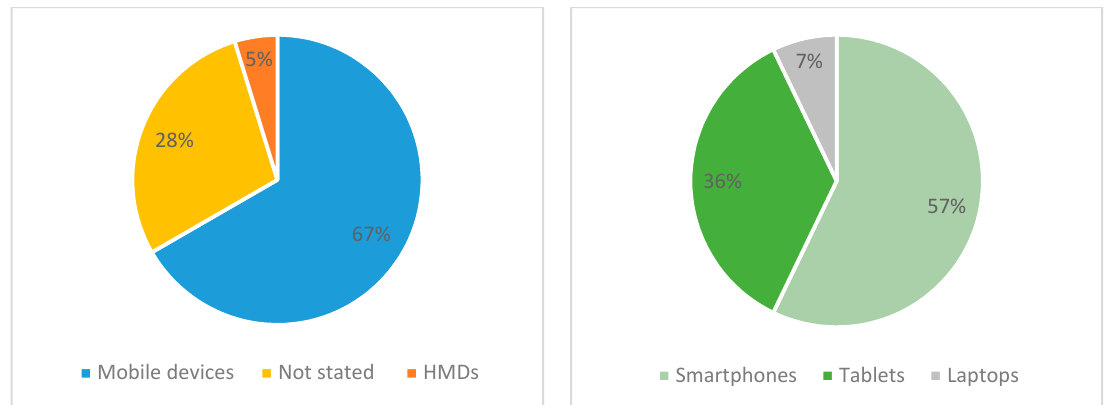
Figure 7. The percentage of applied AR teaching devices. Left : device type, Right : mobile device type.